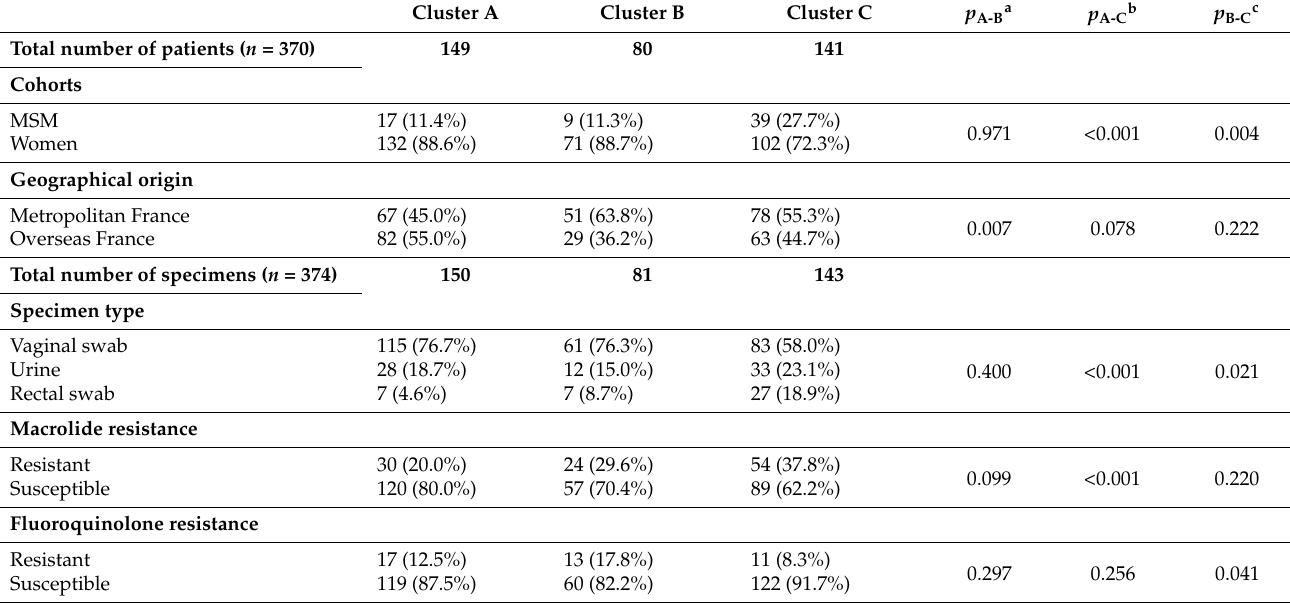
Table 3. Epidemiological characteristics of patients and specimens in the three clusters based on mgpB typing. Cluster A Cluster B Cluster C p A-B a p A-C b p B-C